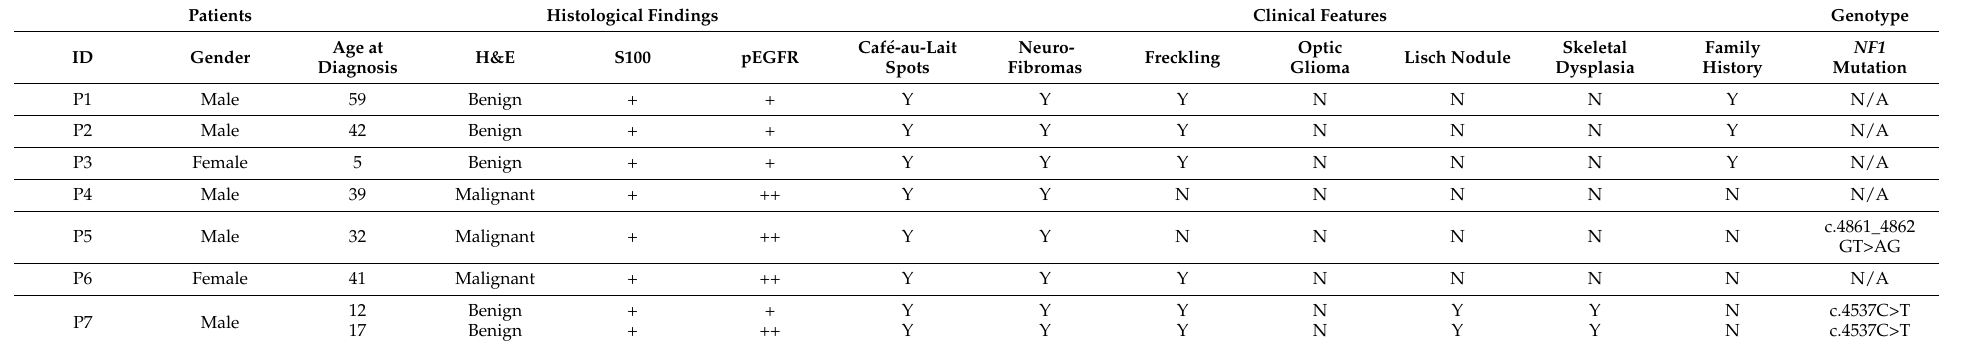
Table 1. Histological findings and clinical characteristics of seven patients with neurofibromatosis type 1, including tumor tissue samples from patient #7 at two different time points (at ages 12 and 17